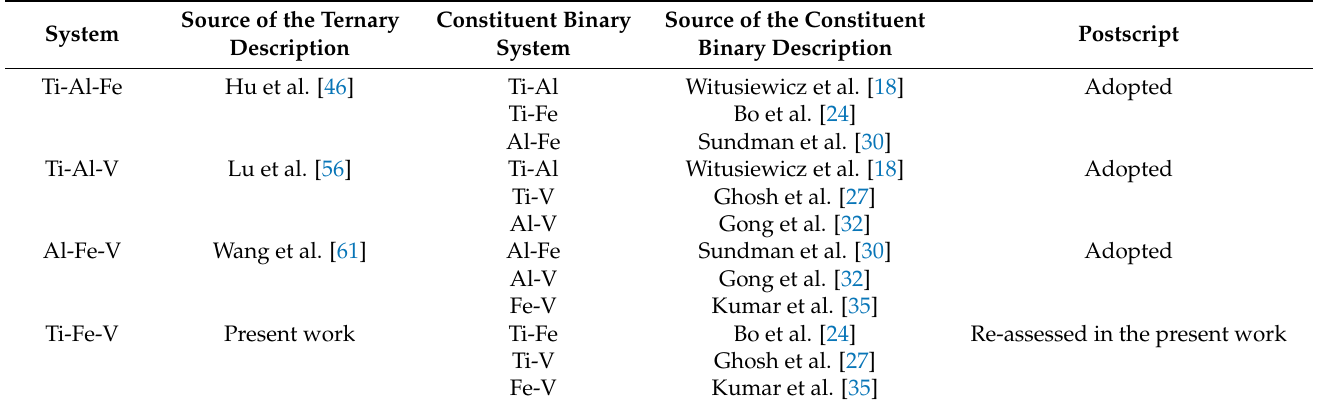
Table 3. Thermodynamic descriptions for constituent ternary sub-systems of the Ti-Al-Fe-V quater- nary system, used in the present